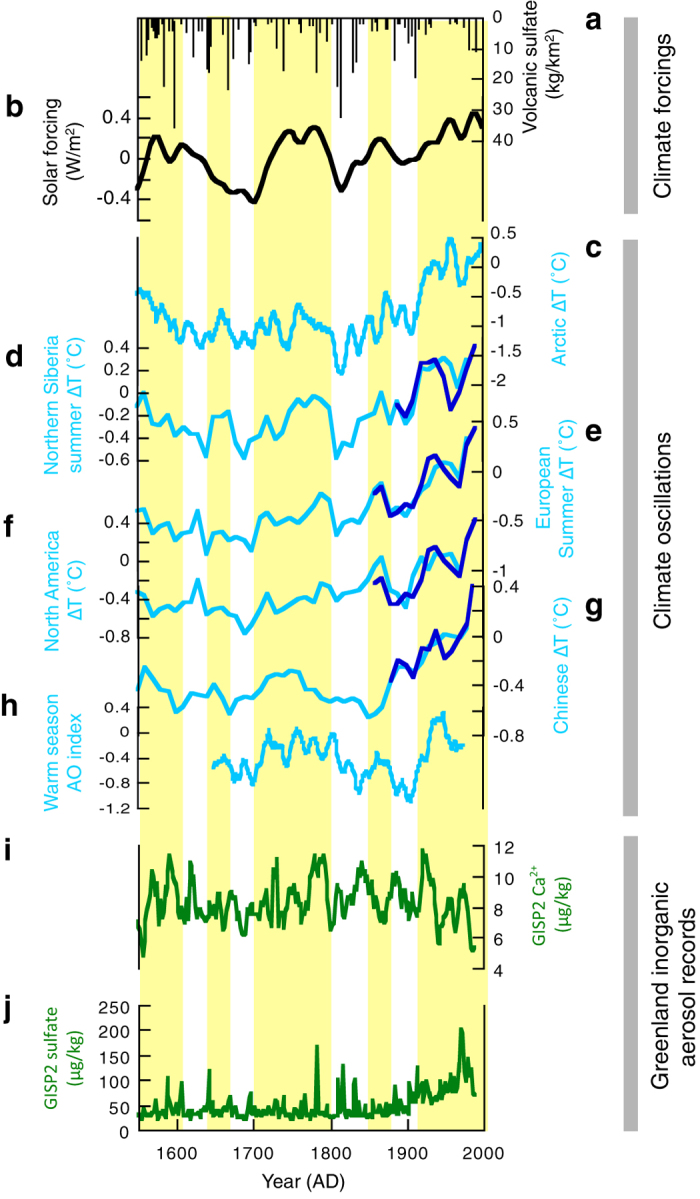
Comparison of inorganic aerosol tracers from the Greenland GISP2 and climate reconstructions over the past 450 years.(a) Volcanic radiative forcing2. (b) Solar radiative forcing1. (c) Reconstructed Arctic annual mean temperatures39. (d) Reconstructed Northern Siberian summer temperatures40. (e) Reconstructed European summer temperatures40. (f) Reconstructed North American annual mean temperatures40. (g) Reconstructed Chinese summer temperatures40. Blue lines in figs (d–g) represent instrumental temperature record. (h) Reconstructed warm season Arctic Oscillation (AO) index47. (i) Concentration of Ca2+ in the GISP243. (j) Concentration of sulfate in GISP243. Yellow shading represents relatively warm periods.